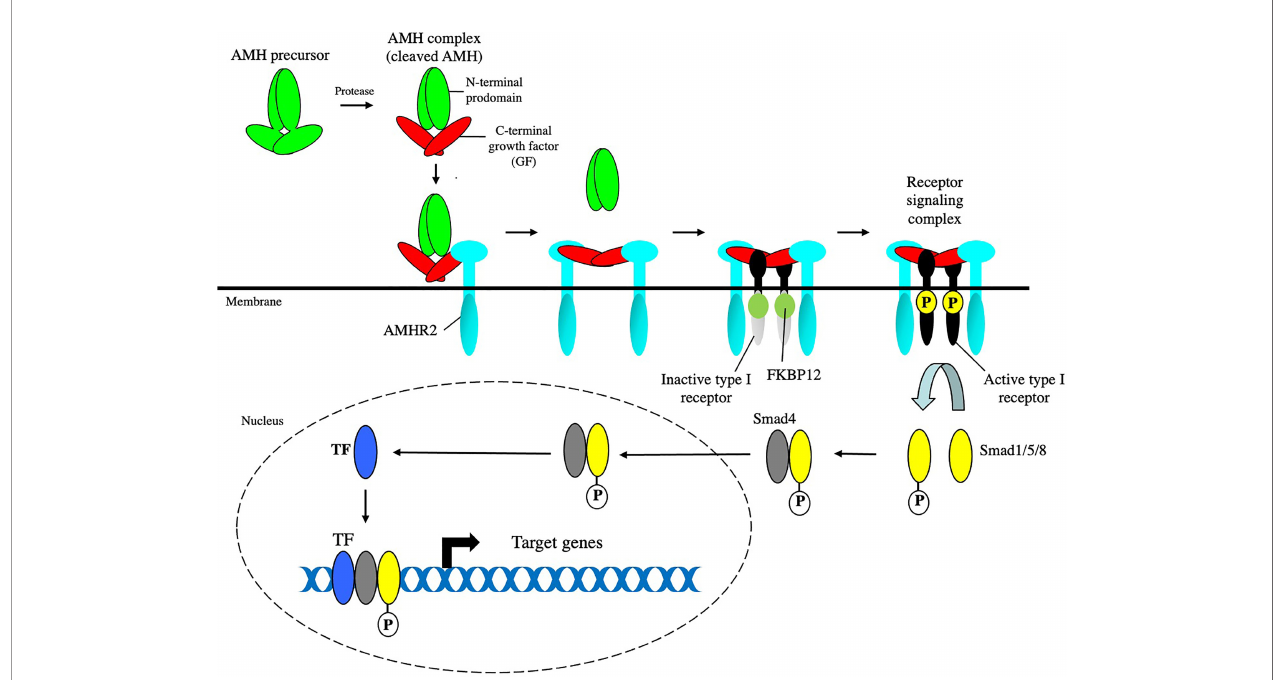
FIGURE 1 | The canonical AMH signaling pathway. AMH assembles a receptor signaling complex composed of type I and type II receptors. The kinase domain of AMHR2 is constitutively active and phosphorylates and activates the kinase domain of the type I receptor (ALK2 or 3), which phosphorylates Smad1, 5, and 8. The phosphorylated Smads form a heterotrimer with Smad4, which translocates to the nucleus, and binds to other transcription factors (TF). The Smad/TF complex binds to promoter or enhancer regions of target genes to regulate